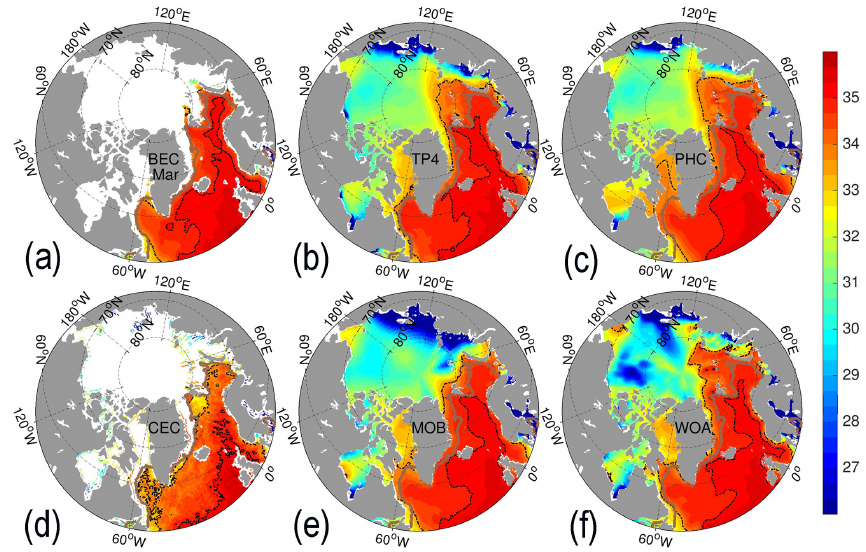
Figure 2. Monthly SSSs (unit: psu) in March from satellite products (BEC and CEC, a, d ), reanalysis or reprocessing (TP4 and MOB, b, e ), and climatology (PHC and WOA, c, f ). White areas are masked by sea ice. The thick brown line represents the sea-ice edge (15% concentration from TP4), and the black shaded isolines represent the salinities of 33.6 and 35psu near the surface.